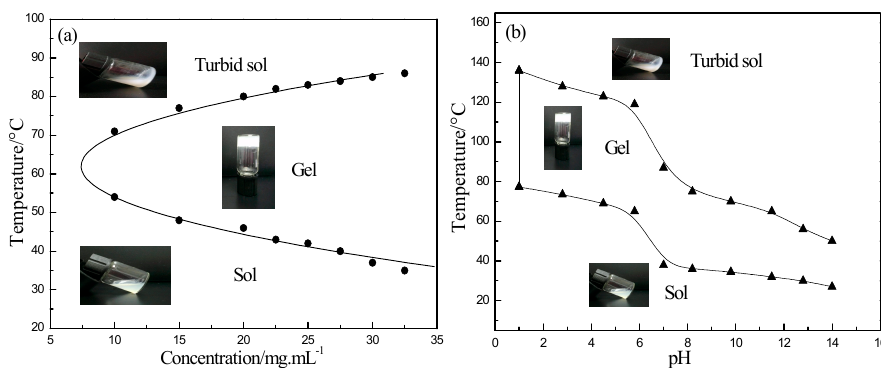
Figure 8. The temperature induced sol–gel phase diagrams of P2 aqueous solution ( a ) and 30 mg·mL − 1 P2 aqueous solution at different pH ( b ).